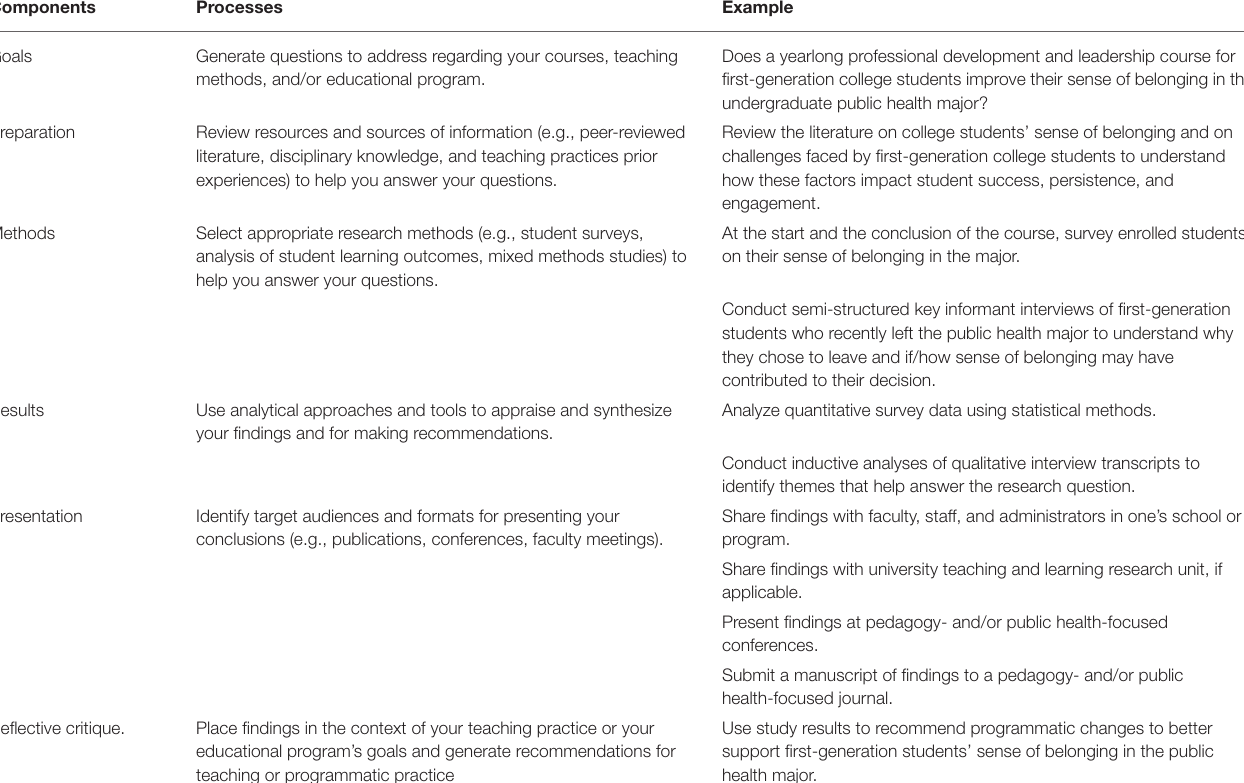
TABLE 1 | Case example of putting the STAP model into practice. Components